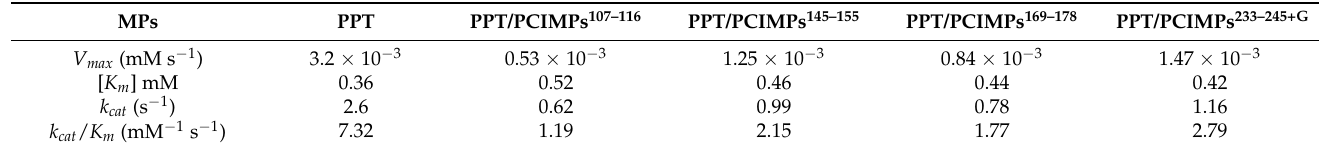
Figure 6. ( a ) Michaelis-Menten and ( b ) Lineweaver-Burk plots of PPT and PPT/PCIMPs obtained with various N -benzoyl- L-arginine ethyl ester (BAEE) solutions (1.5, 1, 0.5 mM). Note: The standard deviation for the Michaelis-Menten kinetics plot of PPT in different concentration (1.5 mM to 0.5 mM) is 1 × 10 –4 whereas and PPT/PCIMPs 233–245+G is 1.41067 × 10 –5 , 7.2111 × 10 –6 , and 5.50757 × 10 –6 for (1.5, 1, and 0.5 mM). Table 2. Kinetic parameters obtained from the Michaelis-Menten